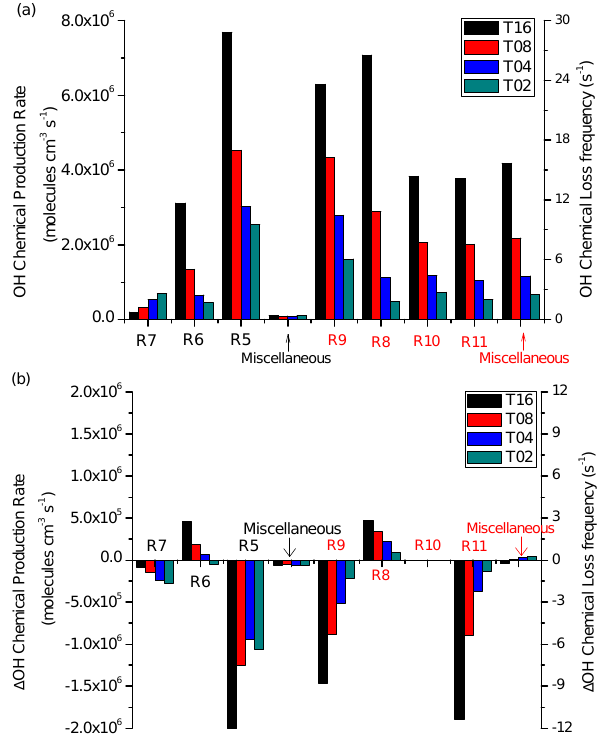
(a) The daily average chemical production rates (la- bels in black) and chemical loss frequencies (labels in red) of OH for the NO DUST simulation. (b) The differences between the DUST H and NO DUST simulations (DUST H − NO DUST). “Miscellaneous” represents the sum of all the other source or loss terms. The bar sequence is the same as in Fig. 5. The reactions are listed in Table